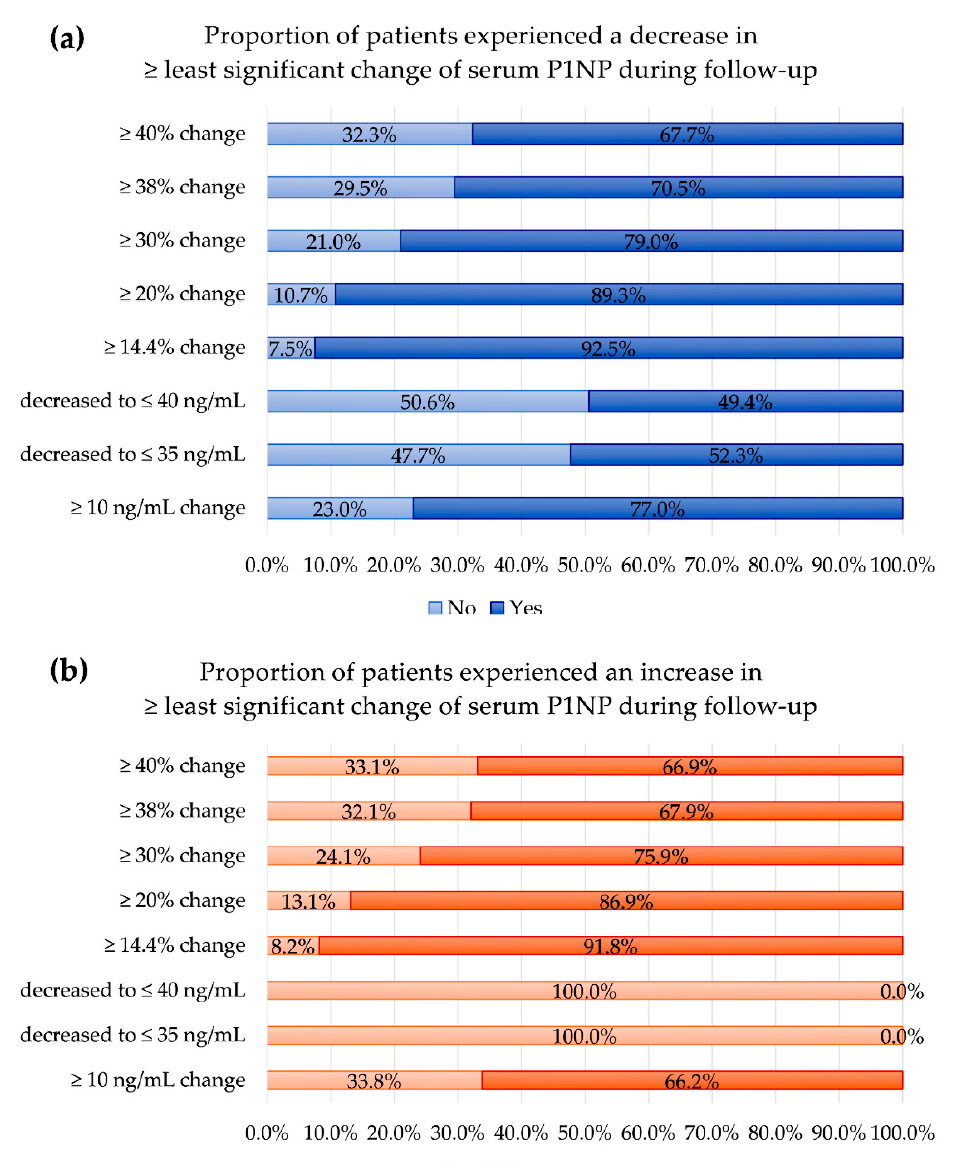
Figure 4. The proportion of patients that experienced changes in serum P1NP exceeding the least significant changes during follow-up: ( a ) in patients experiencing a decrease in serum P1NP and ( b ) in patients experiencing an increase in serum P1NP. ‘No’ represents no achievement of least significant changes, and ‘Yes’ represents an achievement of least significant changes.